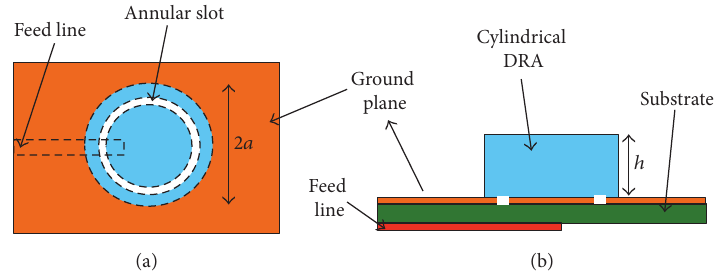
Figure 23: Top (a) and cross-sectional view (b) of a rectangular DRA excited by an annular slot.